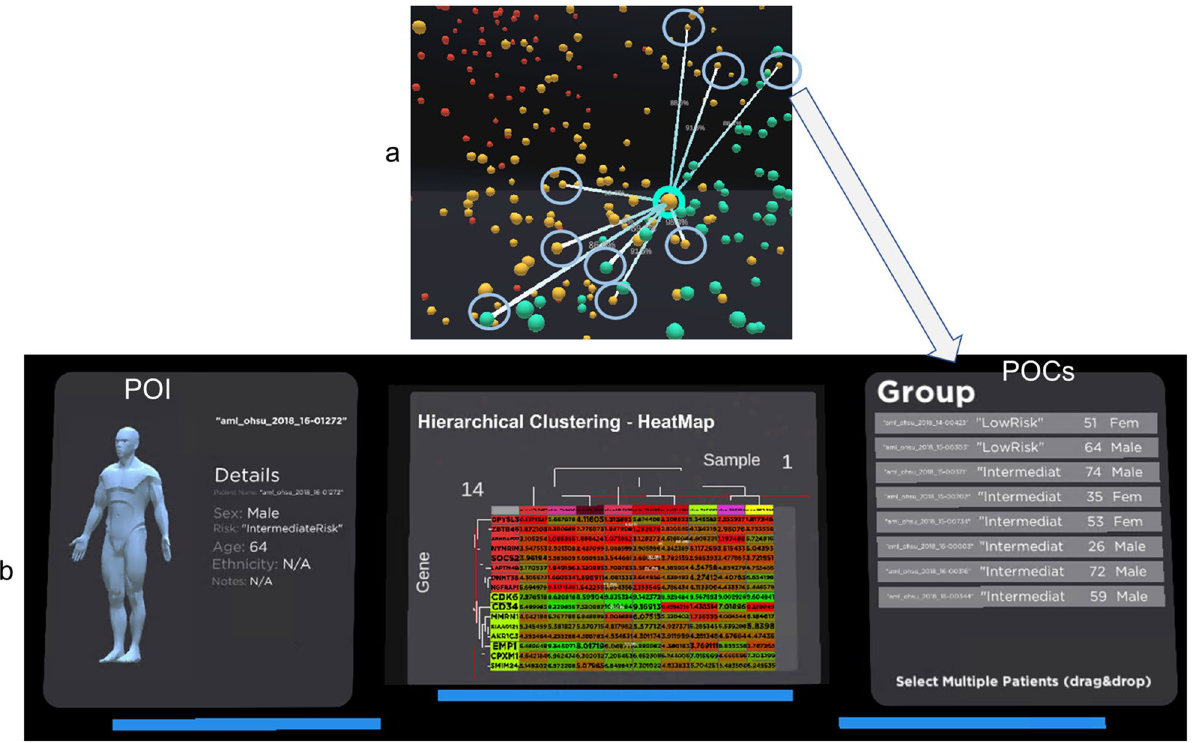
Figure 6. Patient-to-Group comparison panel. The analyst using the decision support system to trigger the selection of POI and POCs in this panel. The primary patient is our POI as shown in ( a ). All POCs are highlighted in light blue in ( a ) and are listed under the group panel in ( b